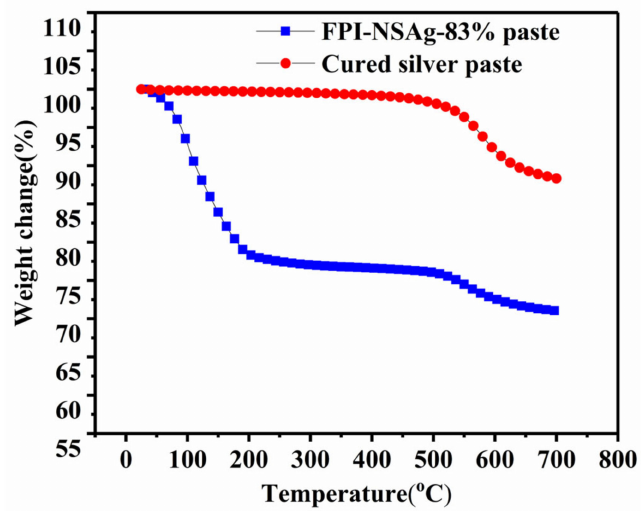
Figure 11. TGAscurvesofnanosilverpaste(FPI-SAg-83%)andcuredsilverpasteundernitrogenatmospheres.